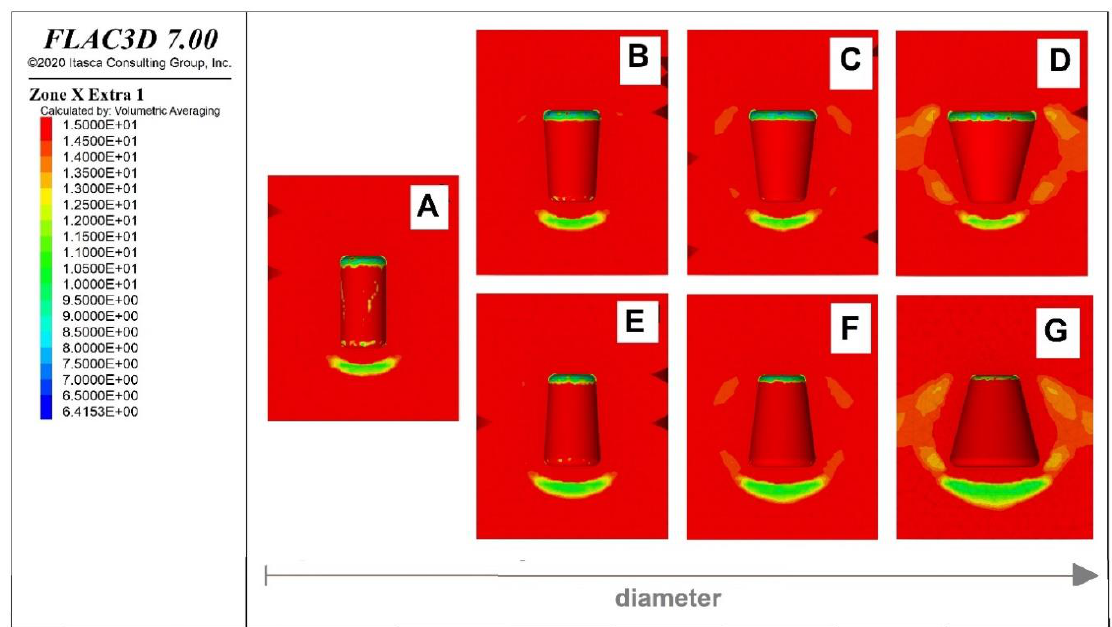
Figure 19. The safety factor (SF) distribution in the caverns with ss1; the first injection period: ( A ) cylindrical, ( B , E ) maximum initial diameter of 75 m, ( C , F ) maximum initial diameter of 90 m, ( D , G ) maximum initial diameter of 120 m.